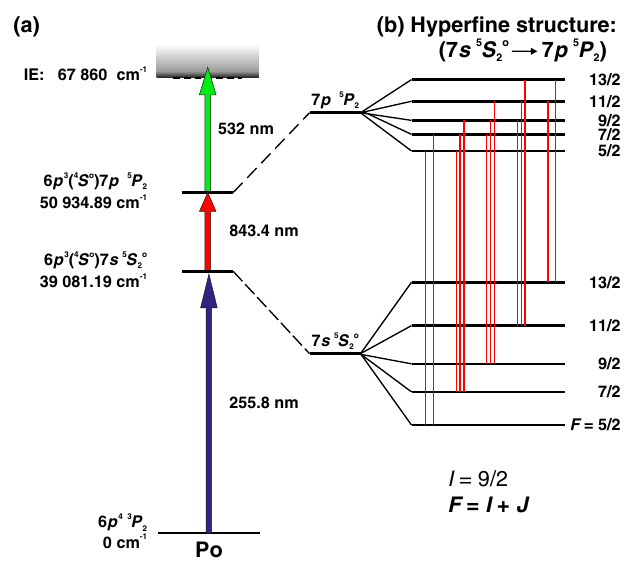
FIG. 2. (a) Three-step laser-ionization scheme for polonium. (b) Close-up of the possible hyperfine levels for the nuclear spin I ¼ 9 = 2 with total angular momentum F and corresponding transitions (solid red lines) for the studied transition from the 7 s 5 S ∘ 7 p 5 P 2 state. The hyperfine structure is not to 2 state to the